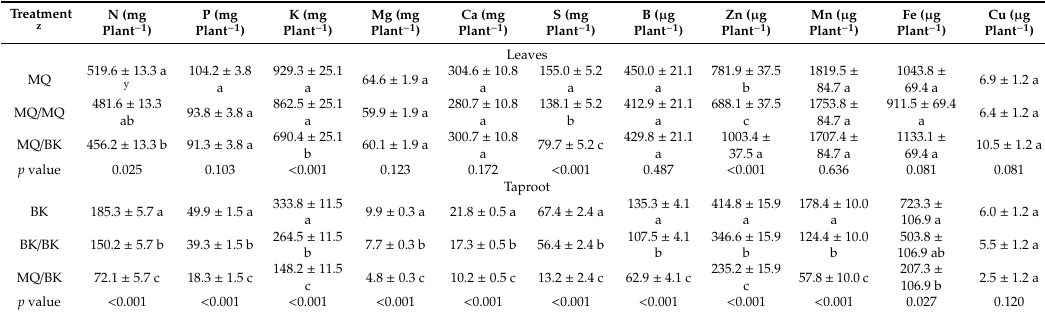
Table 6. Mineral nutrient contents accumulated in leaves of grafted, self-grafted, and non-grafted pac choi and in taproots of grafted, self-grafted, and non-grafted daikon radish plants at harvest in the 2019